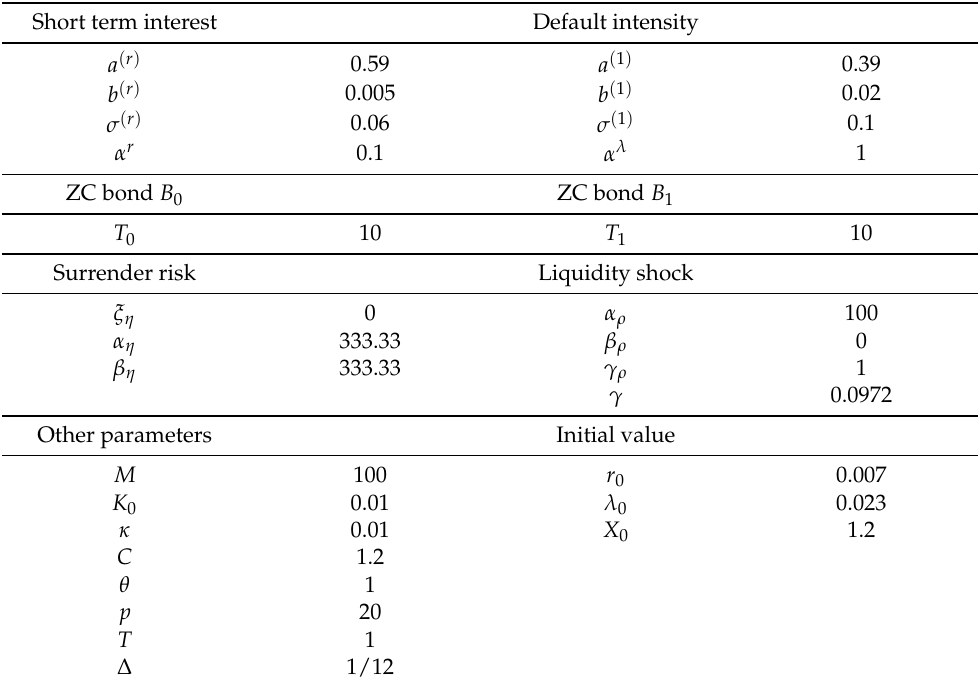
Table 1. Values of parameters in the central